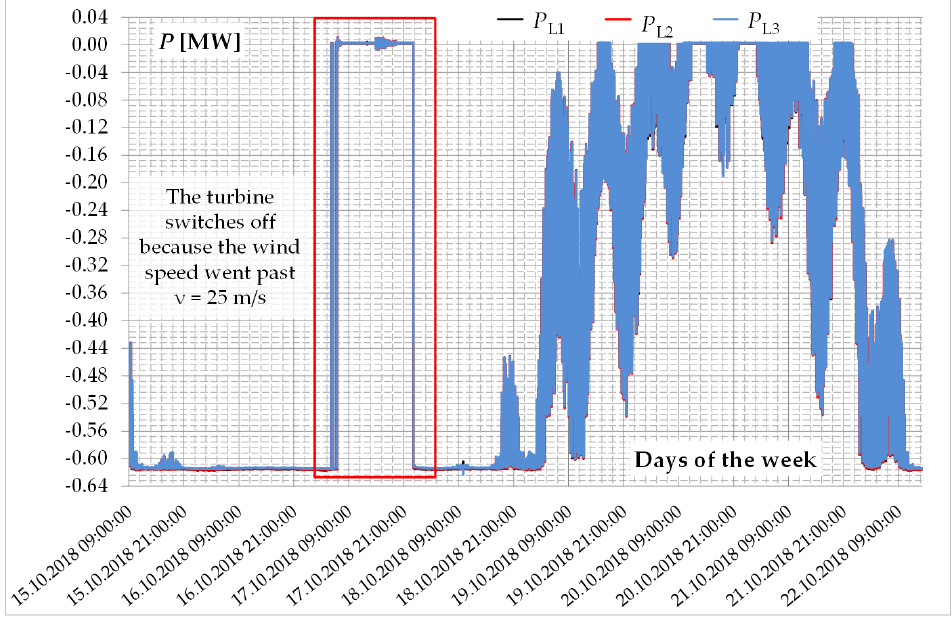
Figure 22. Active power generated by the generating unit during the